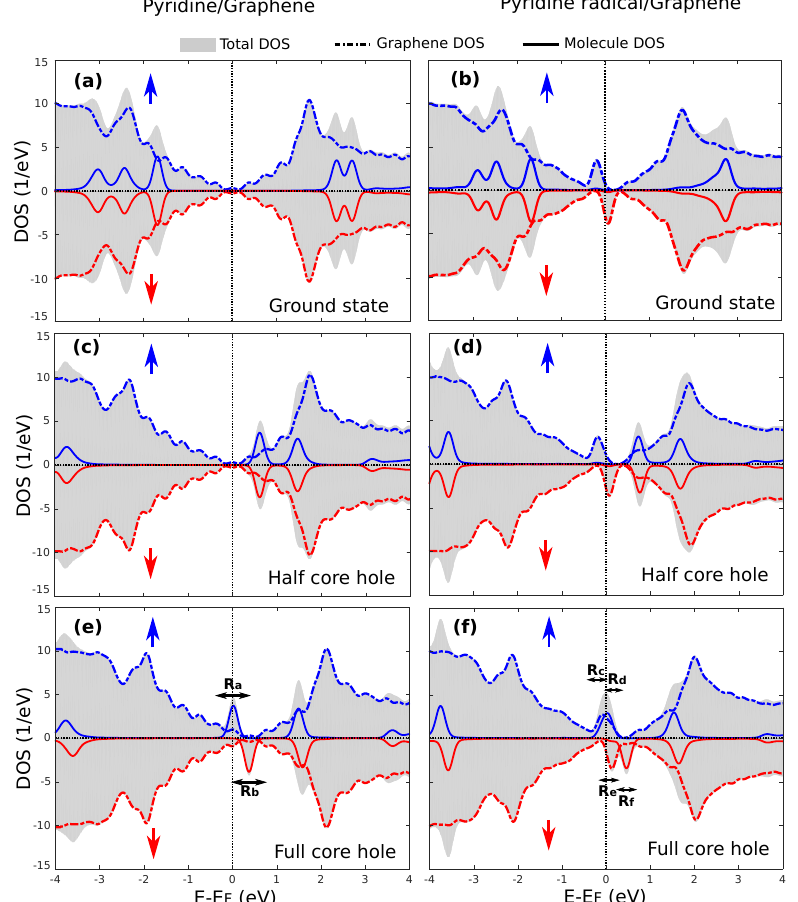
Figure 5. Electronic Densities Of States (DOS), total and projected onto the orbitals of the molecule and on graphene, for ground state ( a ) pyridine/graphene and ( b ) pyridine radical/graphene, half core hole ( c ) pyridine/graphene and ( d ) pyridine radical/graphene and full core hole ( e ) pyridine/graphene and ( f ) pyridine radical/graphene. Positive/negative values indicate spin-majority/-minority populations, respectively. Arrows in ( e , f ) mark energy ranges for reference in Figure